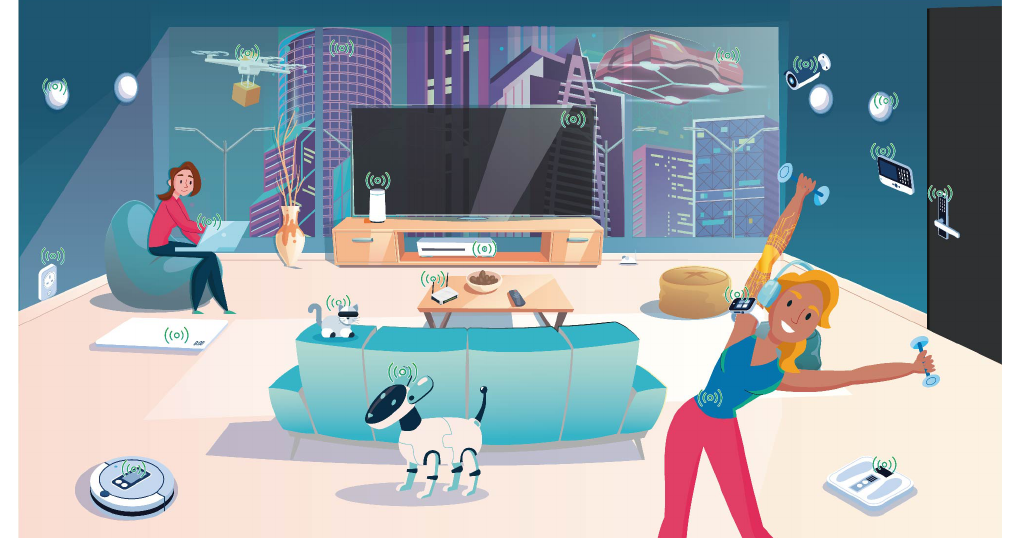
Figure 13. Current and future battery applications in daily life, including health monitoring, commu- nication, transportation, entertainment, working, lighting, cleaning, and so on. Graph constructed by the